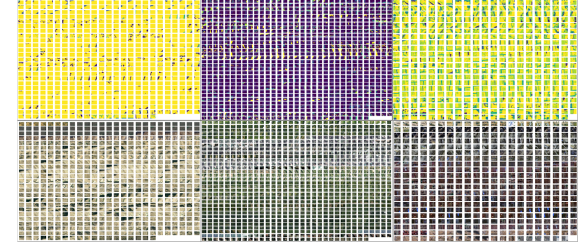
Figure 4. Cluster result, upper side: labels, lower side: images.